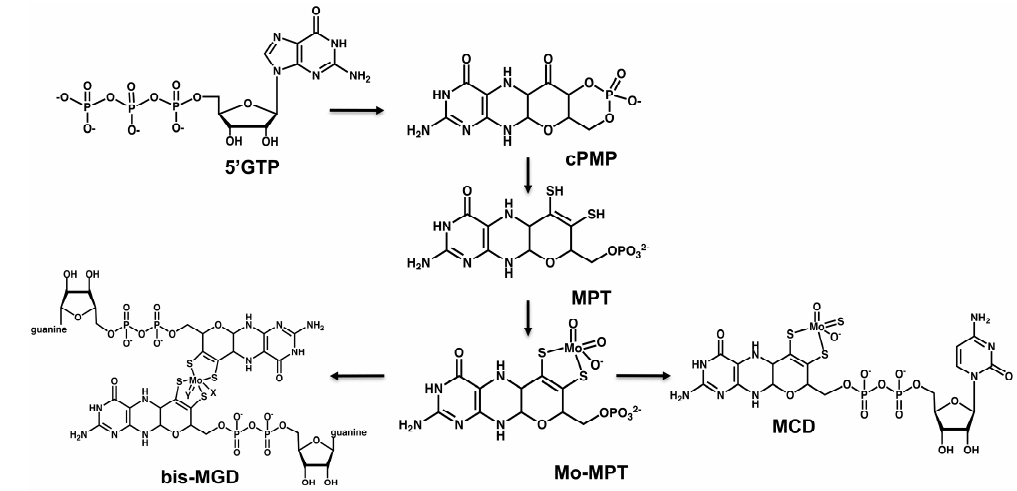
Figure 2. Scheme of the biosynthesis of Moco. Shown are the structures of the stable intermediates of the biosynthesis of Moco. The central part shows the three conserved steps of Moco biosynthesis present in all organisms, the formation of cPMP, MPT and Mo ‐ MPT from 5 ′ GTP. In bacteria, Mo ‐ MPT can be further modified by the addition of GMP or CMP, forming the bis ‐ MPT guanine dinucleotide cofactor ( bis ‐ MGD) or the MPT cytosine dinucleotide cofactor (MCD), respectively.